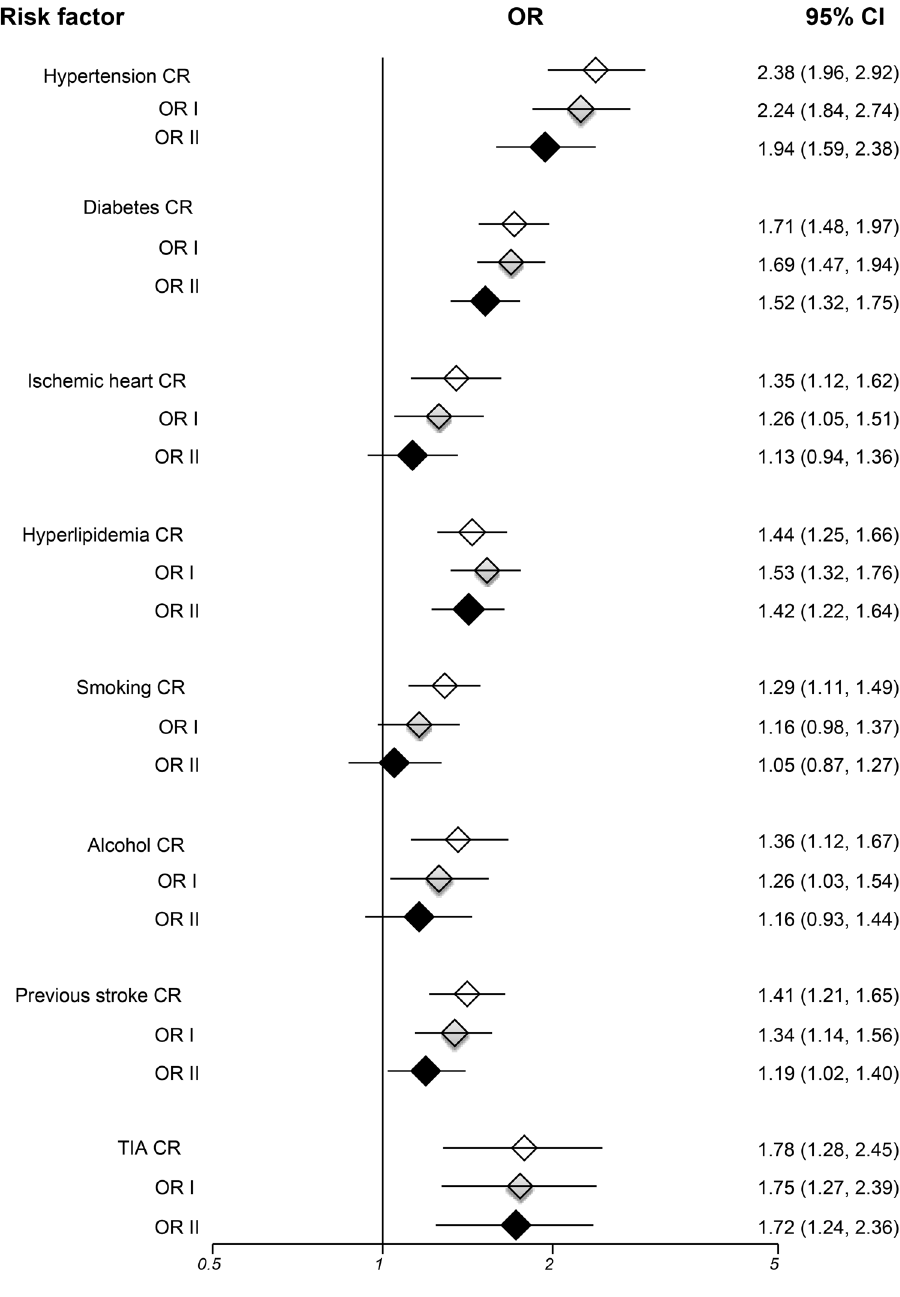
Figure 1. Risk factor analyses for large artery atherosclerotic strokes versus other ischemic subtypes in TOAST classification. IS = ischemic stroke; LAA = large artery atherosclerosis; OR = odds ratio; CR = crude odds ratio; OR I = adjusted odds ratio I; OR II = adjusted odds ratio II; TIA = transient ischemic attack; CI = confidence interval; Horizontal lines represent 95% CIs. Diamonds represent pooled